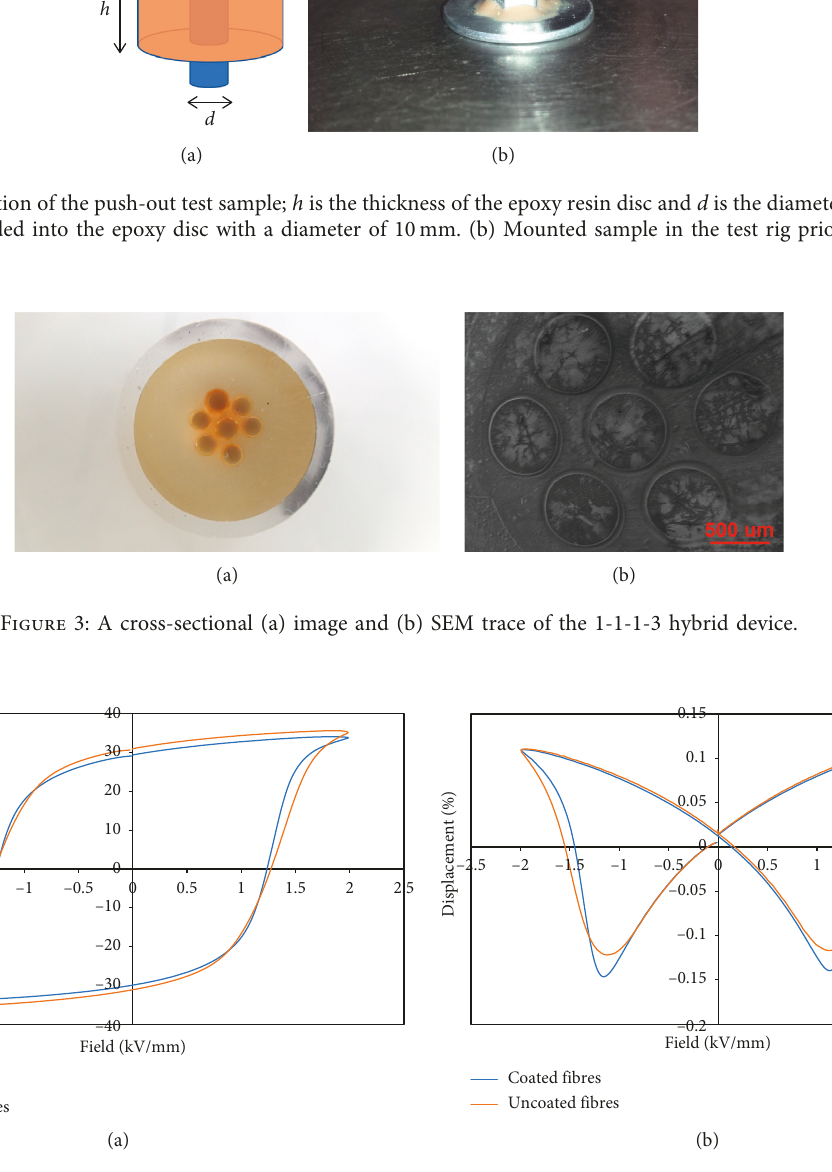
Figure 4: The average (a) polarization evolution (PE) loop and (b) the strain evolution (SE) loop results from 3 fibres, each tested with no significant differences in the ferroelectric properties between fibres coated with the interlayer polymer (Beckopox EM 2120w/45WA) and the uncoated fibres. Table 1: (a) The small signal dielectric and piezoelectric data and (b) the large signal ferroelectric data of the coated and uncoated PZT fibres.